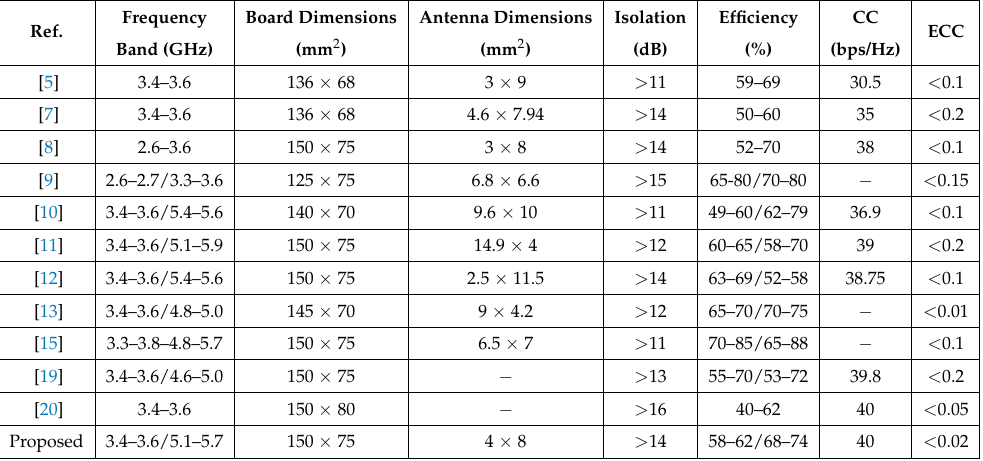
Table 2. Comparison of proposed MIMO antenna with state-of-the art literature.